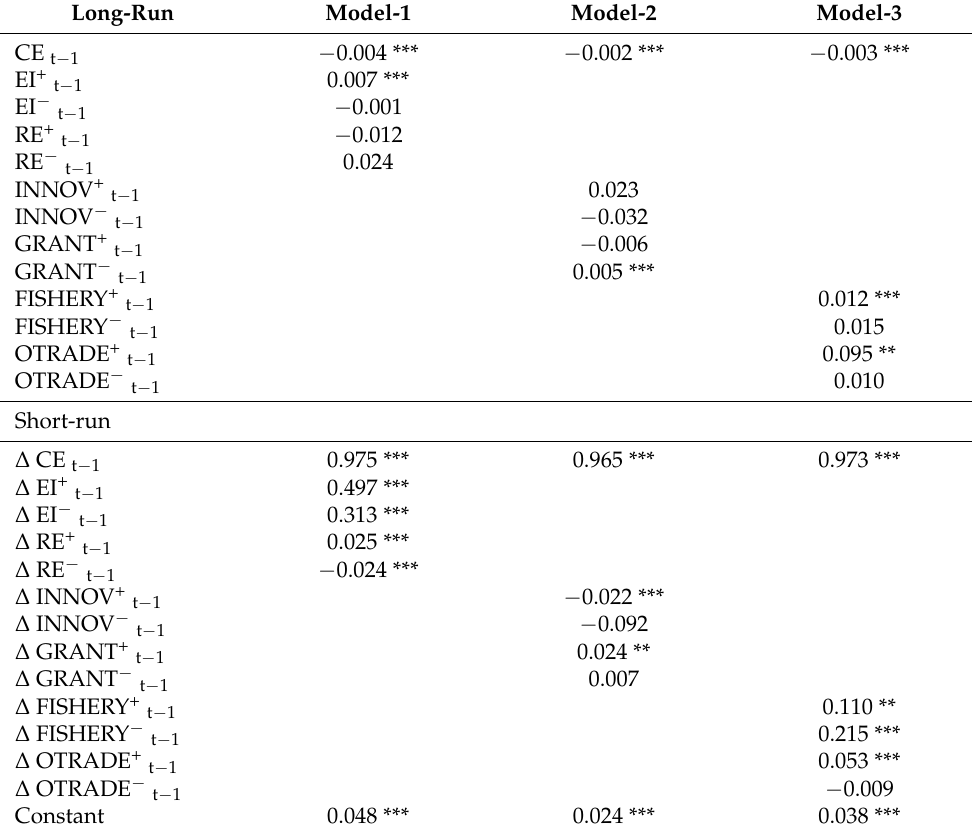
Table 9. Nonlinear ARDL estimation (before Vision